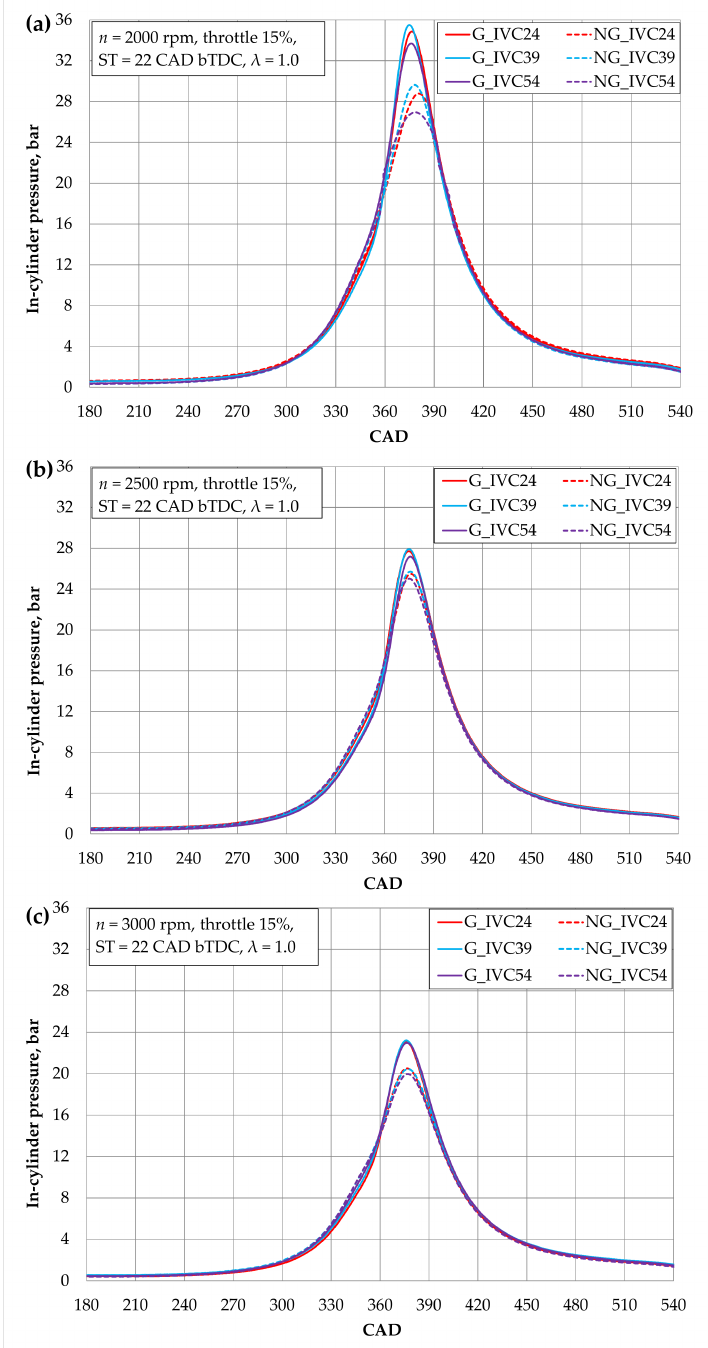
Figure 5. Changes in in-cylinder pressure with the engine running on gasoline and natural gas and while changing the intake valve close timing: ( a ) 2000 rpm; ( b ) 2500 rpm; and ( c ) 3000 rpm. When the engine was running on natural gas (NG_2000), the maximum in-cylinder pressure was significantly reduced (Figure 5a) compared to gasoline, as NG degraded the engine’s volumetric efficiency by introducing less energy to the cylinder. The